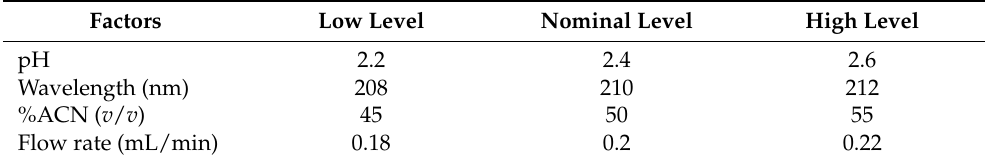
Table 7. Experimental factors and levels.